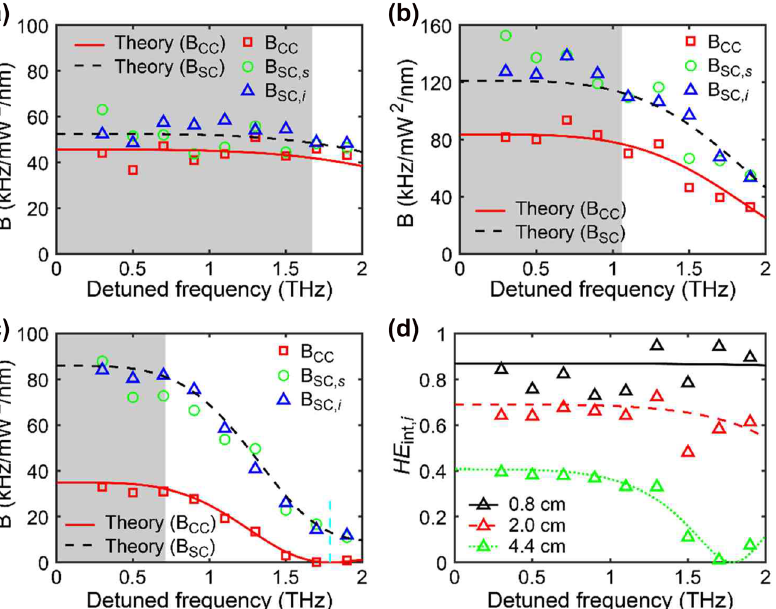
Figure 3: Brightness against the detuned frequency for the waveguide lengths of (a) 0.8 cm, (b) 2.0 cm, and (c) 4.4 cm. The red squares ( B ), and blue triangles ( B ) are the experimental data. The theoretical fit using Eqs. (11) and (12) are shown as solid red and dashed black circles ( B SC , s SC , i lines, respectively, atop the experimental data. The vertical dashed cyan line in (c) shows where Δ kL = 2 𝜋 for L = 4.4 cm, and the grey regions represent where the detuned frequency for Δ kL < 1. (d) Intrinsic heralding efficiency of idler photons versus the detuned frequency for various ) are the experimental data for L = 0.8 cm, 2.0 cm, and 4.4 cm, respectively. The waveguide lengths. The black, red, and green triangles ( HE int , i theoretical fits for various lengths are shown atop the experimental